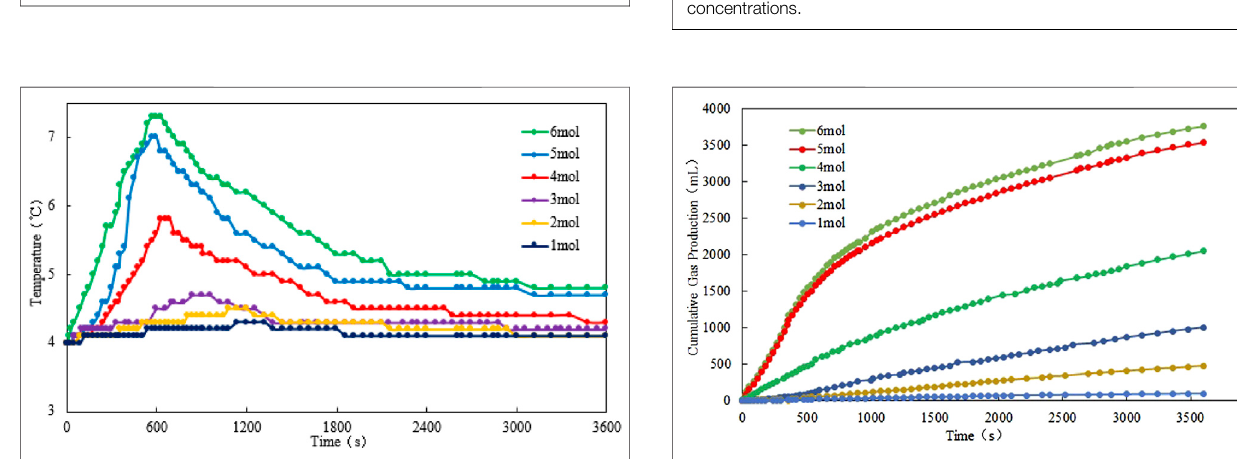
FIGURE 8 | Temperature vs. time at different reactant concentrations.